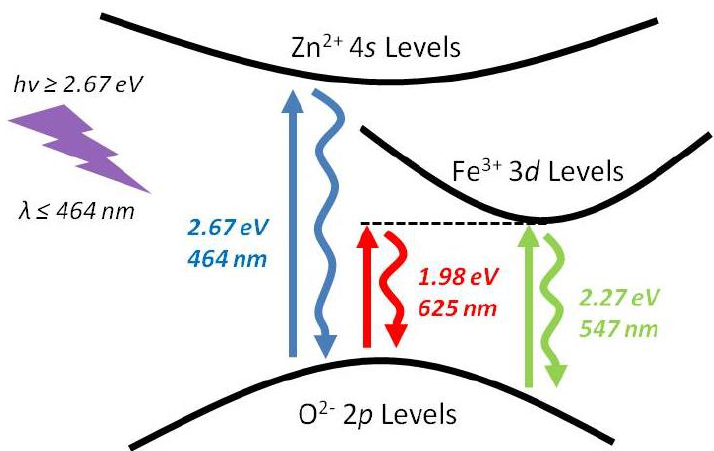
Figure 6. Scheme of the electronic transitions observed for ZFO when photons with wavelengths shorter than 464 nm (energy higher than 2.67 eV) are used for the excitation.